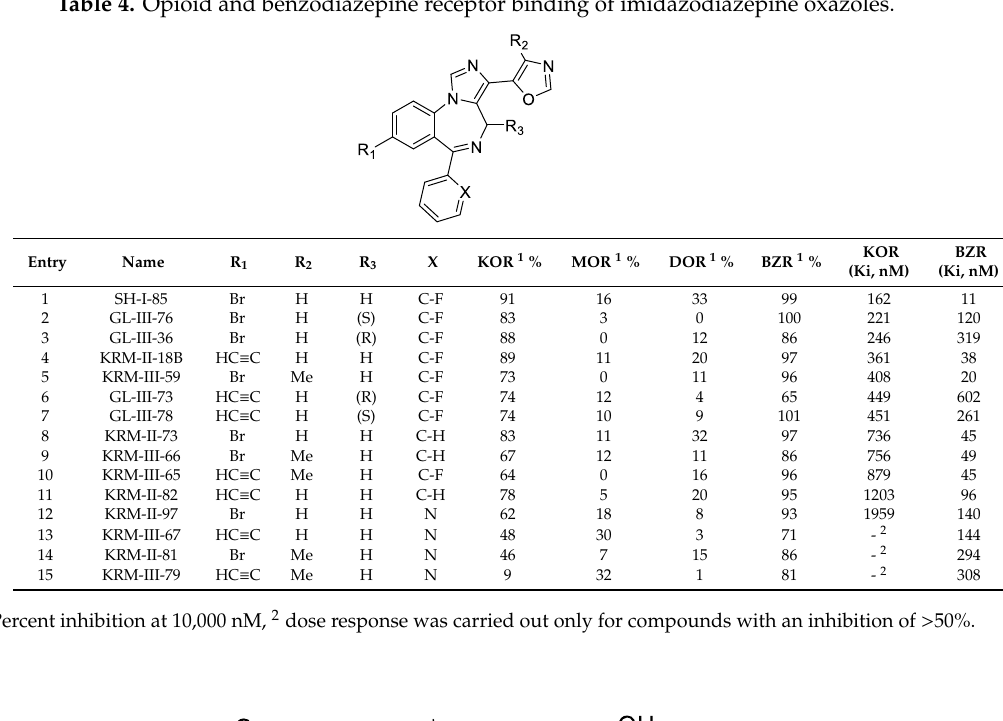
Table 4. Opioid and benzodiazepine receptor binding of imidazodiazepine oxazoles.